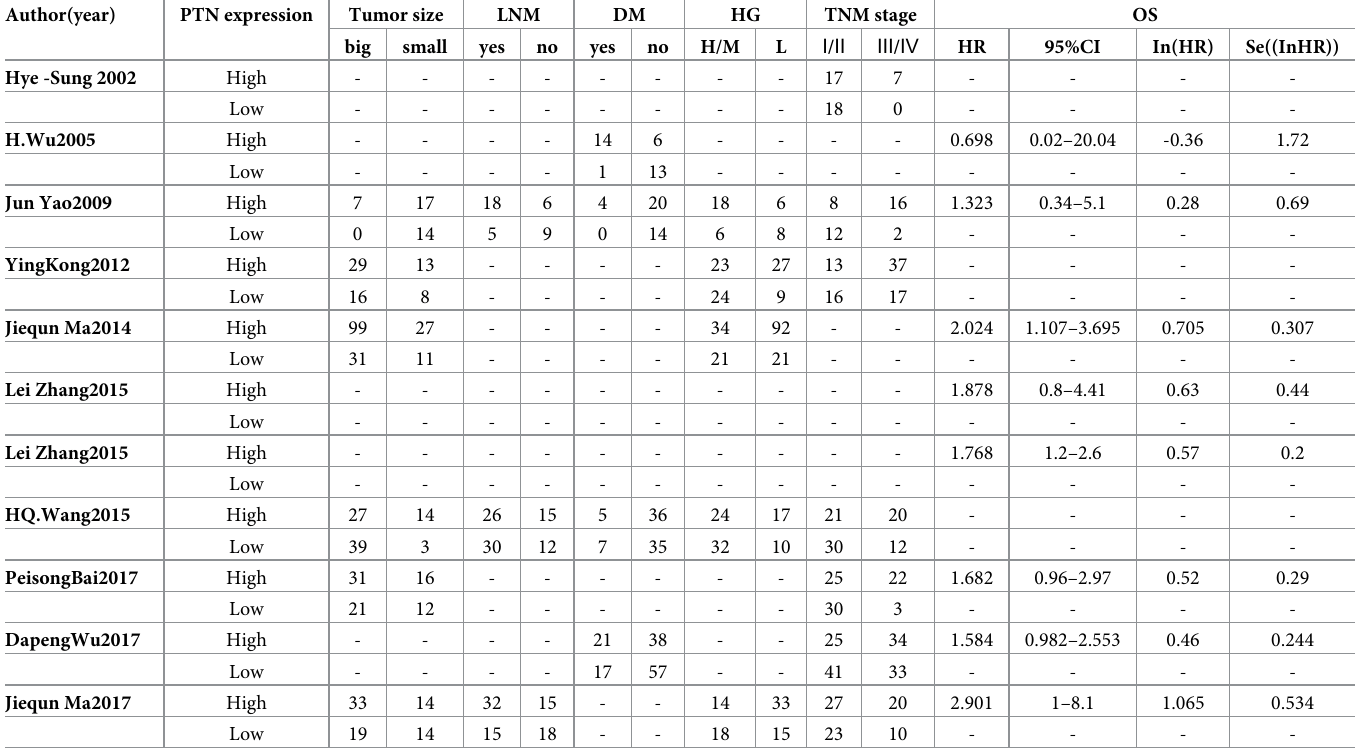
Table 2. The research results of all included studies in the